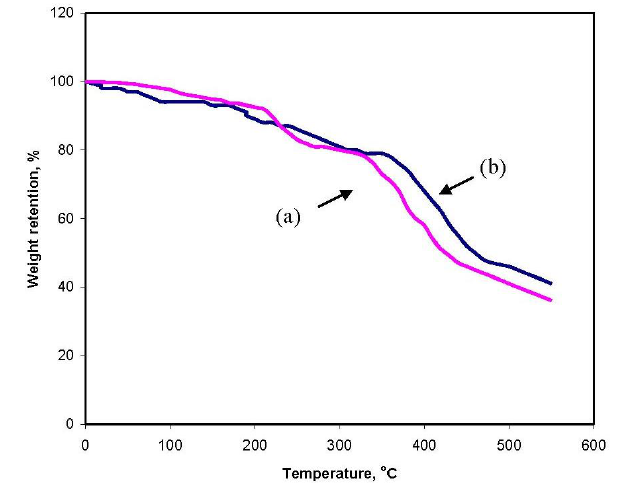
Figure 5. TGA curves of (a) gelatin and (b) gelatin- g -PMAA.